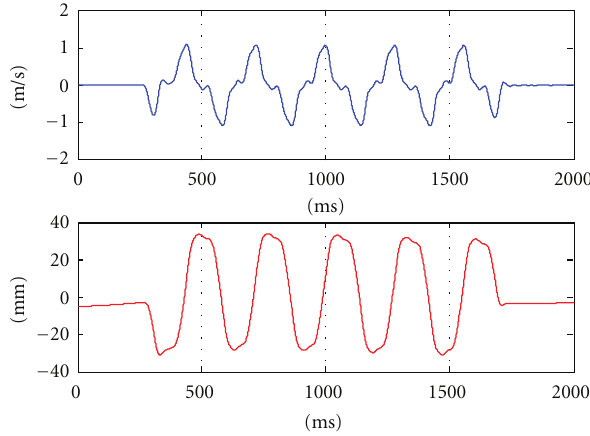
Figure 15: Sample vertical velocities and displacements of the robot end e ff ector measured at a grid point of the